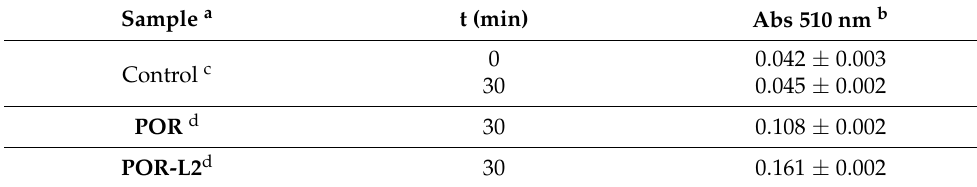
Table 2. Obtained absorbances for the tested porphyrans after 30 min in the ferric reduction activ- ity